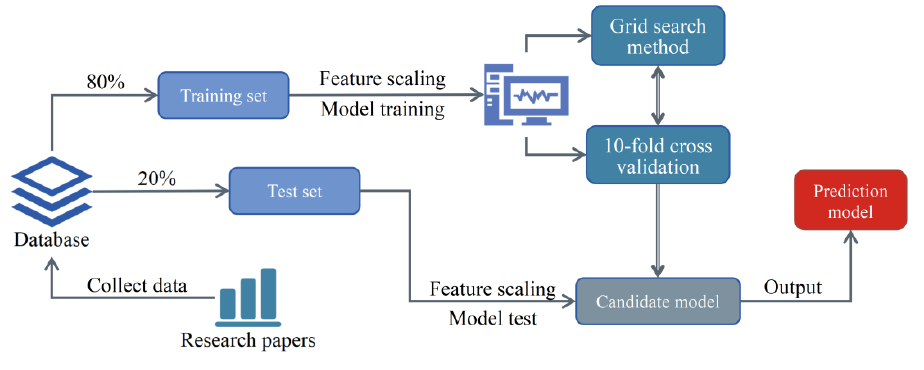
Figure 4. Flowchart of ML modelling.